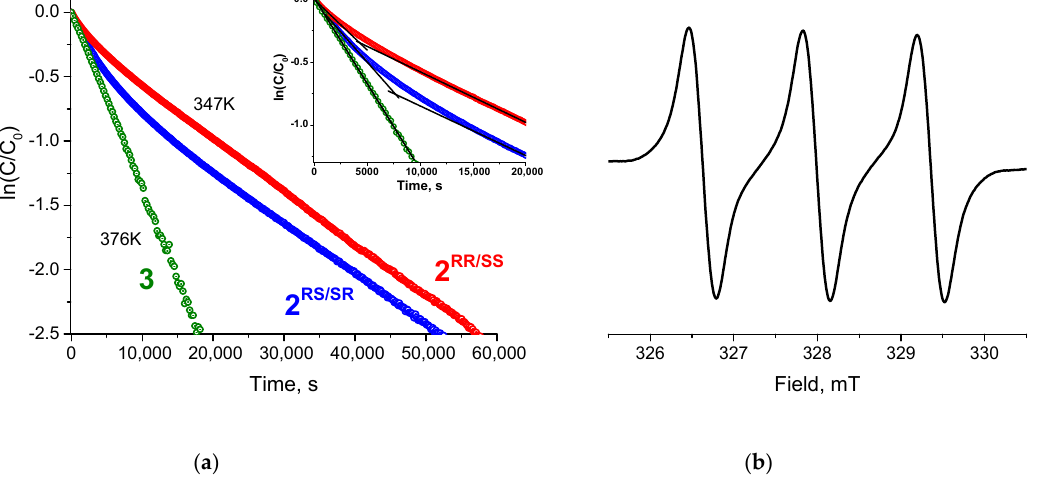
Figure 5. ( a ) Kinetic curves of alkoxyamine decomposition at semi-log scale of 3 at 376 K (green); 2 RS / SR (blue) and 2 RR / SS (red) at 347K in toluene (left) measured using the second integral of EPR spectrum of formed radical 1 • (right); ( b ) EPR spectrum of formed radical 1 •